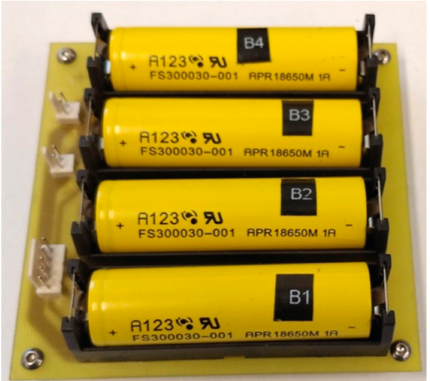
Figure 1. Tested B1-B4 battery pack (proprietary